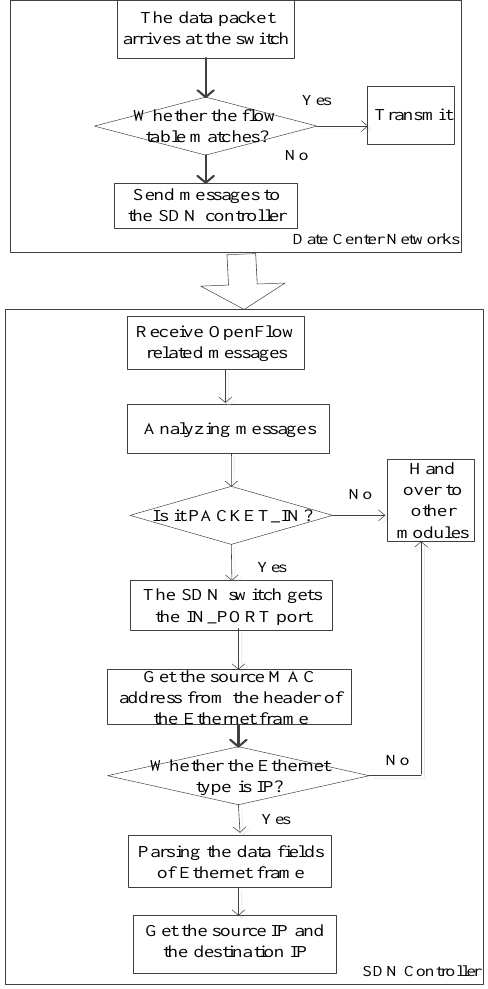
Figure 2. Packet analysis process.